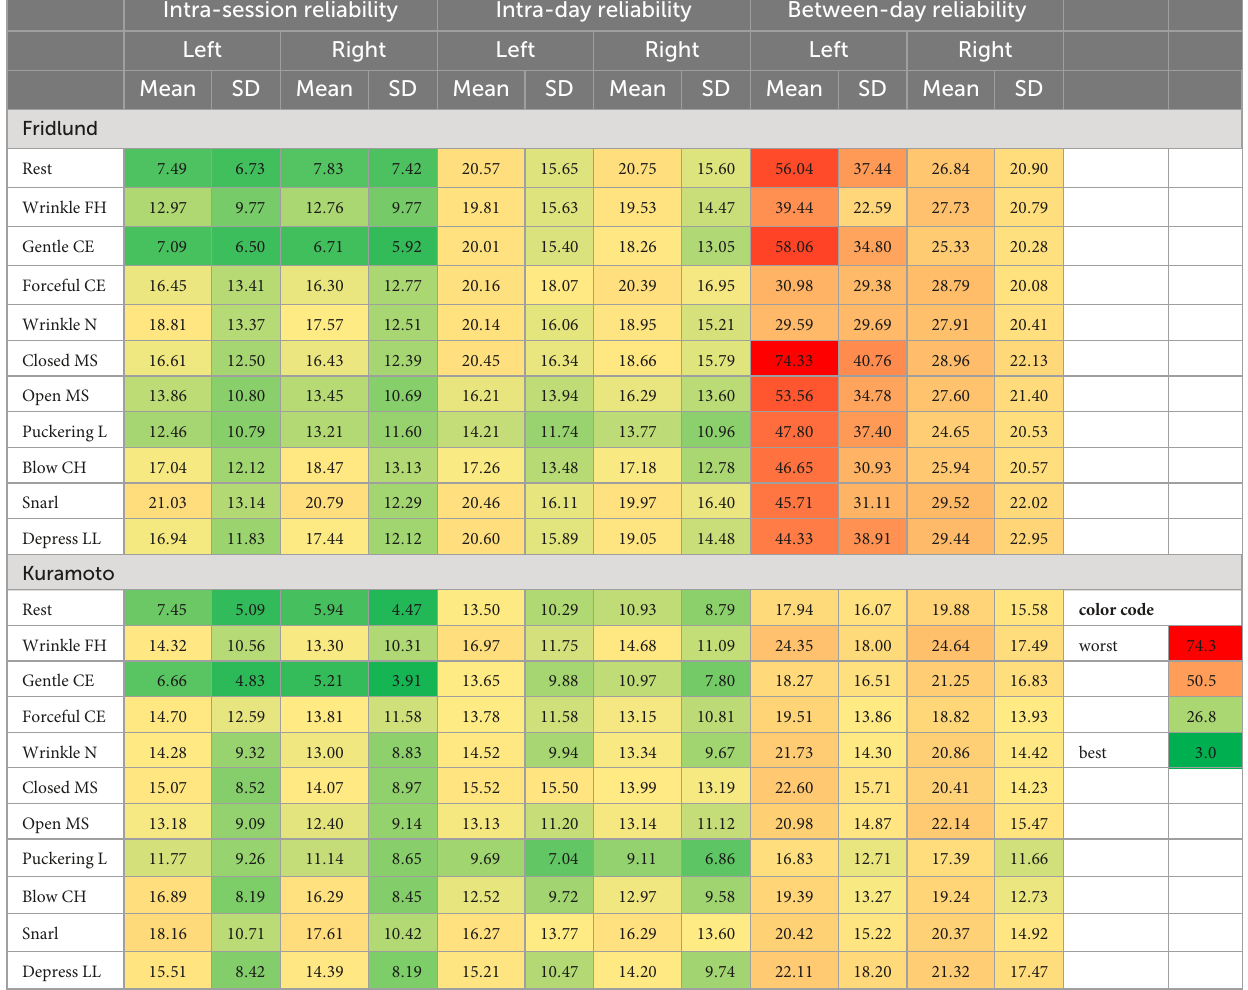
TABLE 4A Coefficient of variation statistics: Test and re-test reliability of the surface EMG recordings during the different facial movement tasks for the Fridlund and the Kuramoto scheme*. Intra-session reliability Intra-day reliability Between-day reliability Left Right Left Right Left